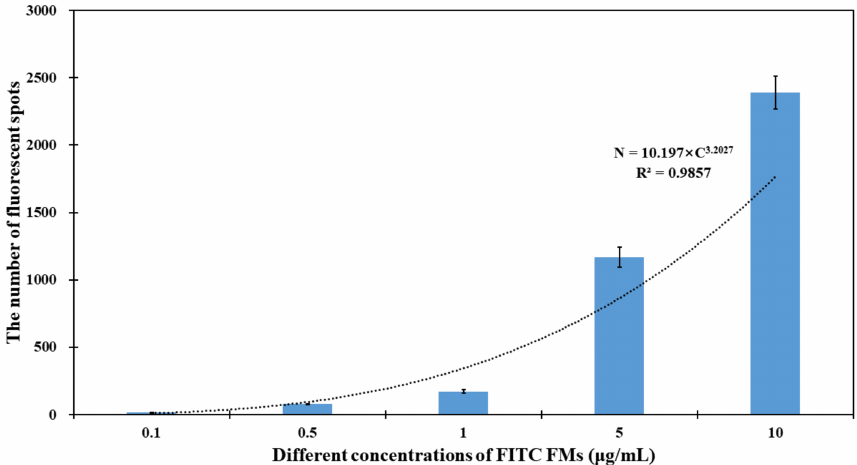
Figure 1. The relationship between the identification results and the concentration of FITC